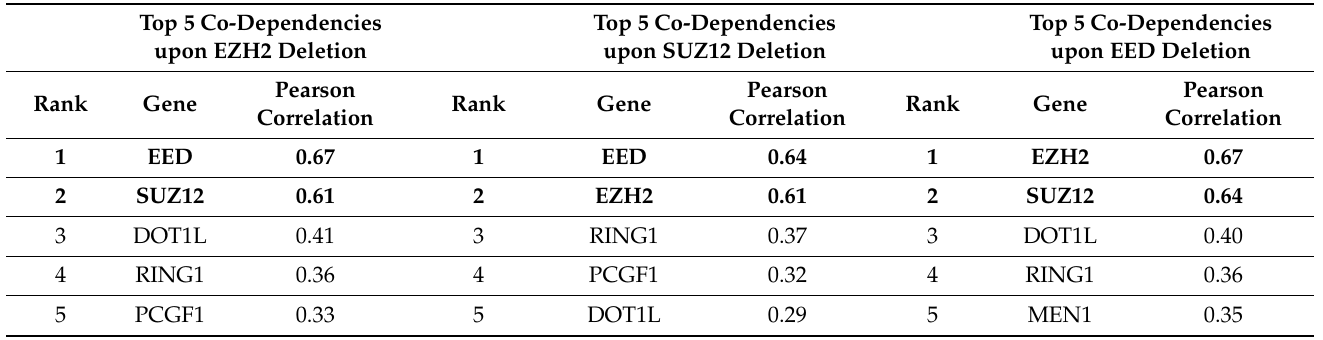
Table 2. The Top Co-dependency Pearson correlations upon knockout of PRC2 components by CRISPR/Cas9 technology in tumor cell lines (DepMap project data). Bold—subunits of PRC2 complex.